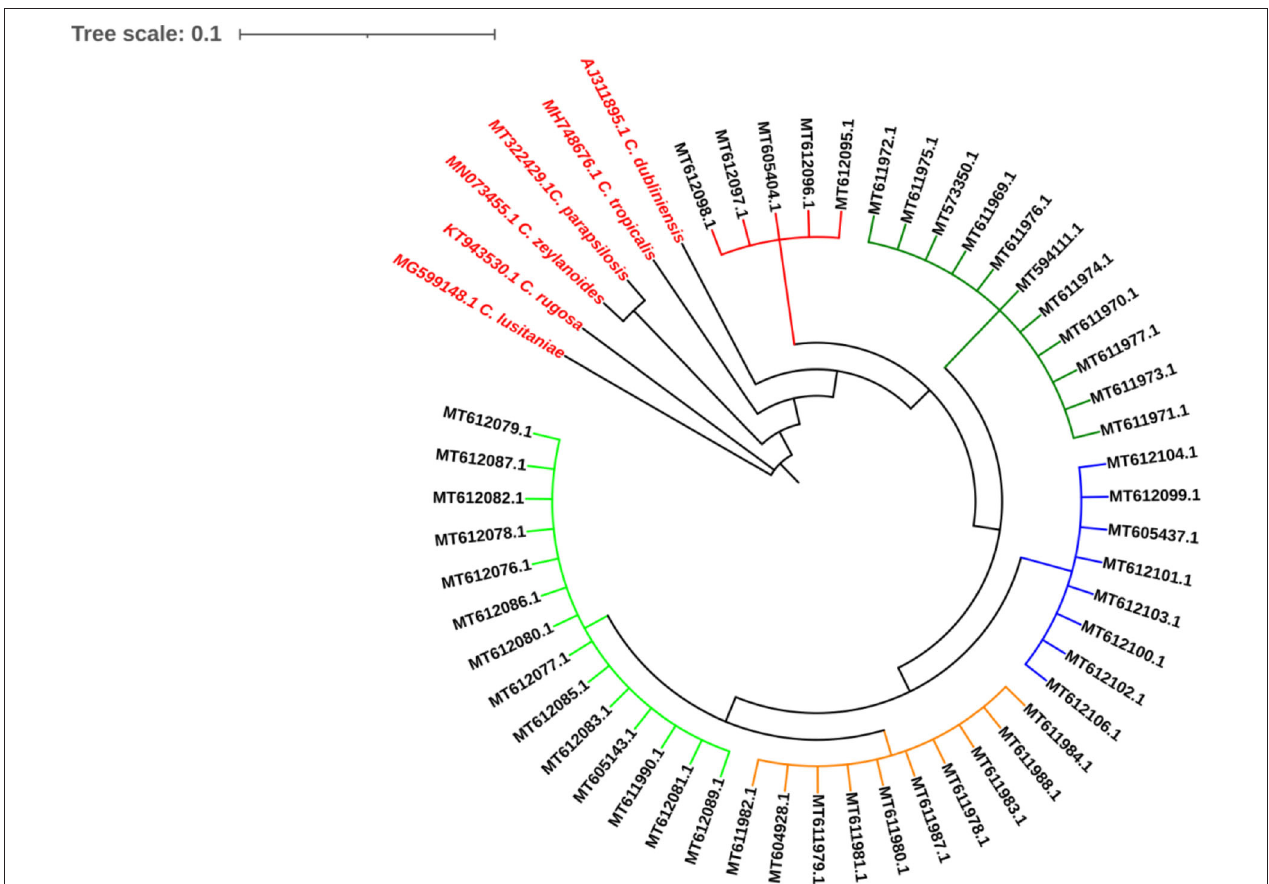
FIGURE 3 | The isolates were genetically identified as Candida albicans and clustered in five clades as shown in figure.